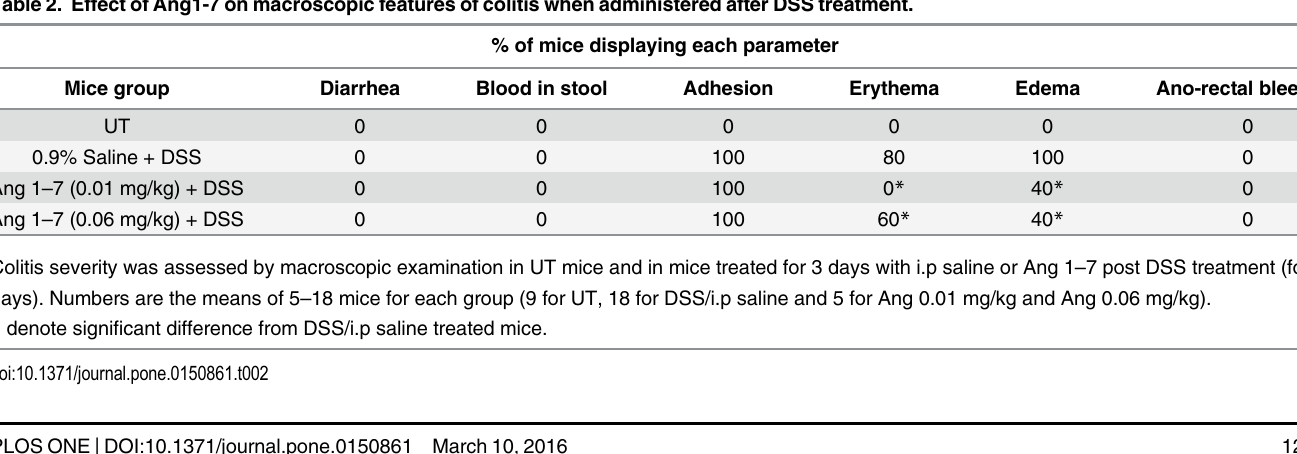
Table 2. Effect of Ang1-7 on macroscopic features of colitis when administered after DSS treatment. % of mice displaying each parameter Mice group Diarrhea Blood in stool Adhesion Erythema Edema